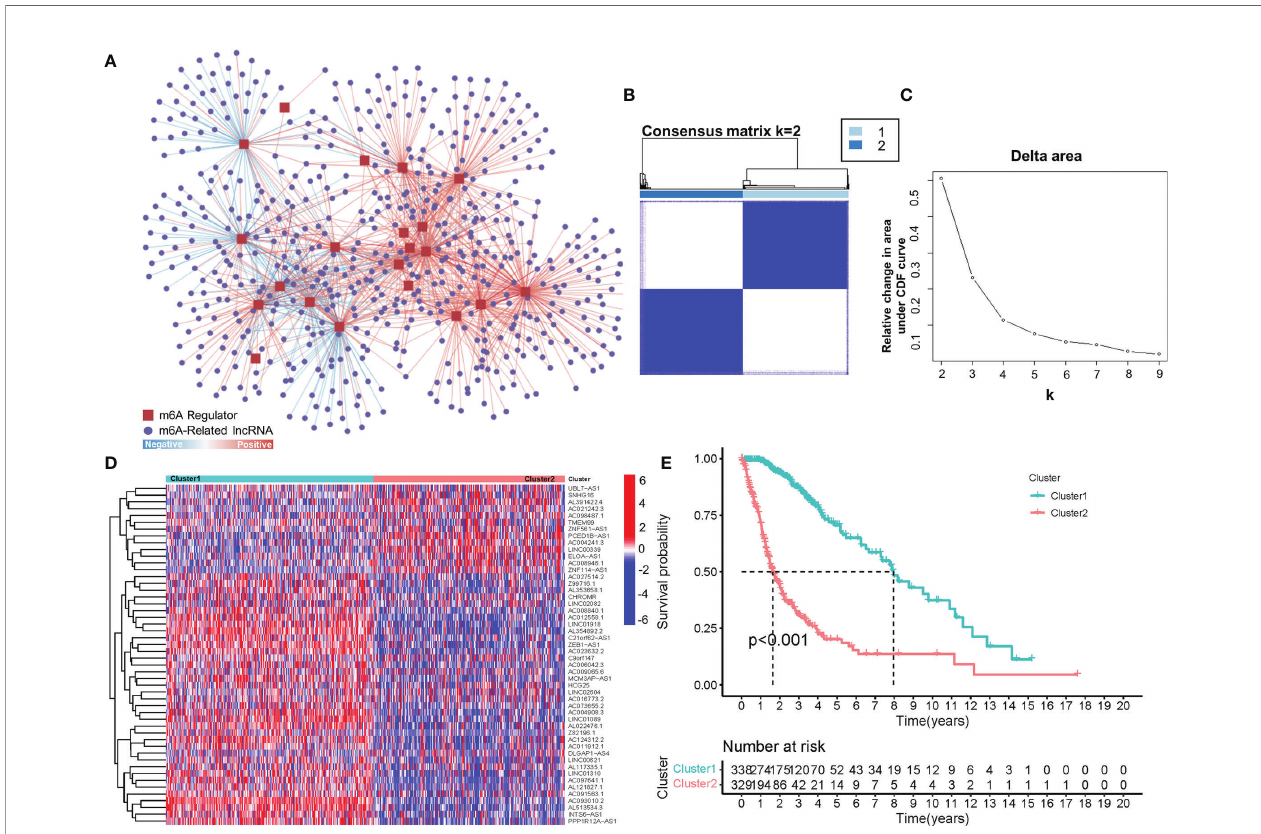
FIGURE 1 | (A) The coexpression network of m6A regulators and m6A-related lncRNAs. (B) Consensus matrix of the consensus clustering based on the m6A- related lncRNAs for optimal k = 2. (C) Area under the CDF curve increment for k = 2 to 9. (D) The heatmap of 50 randomly m6A-related lncRNAs in 2 clusters. (E) Overall survival of patients (TCGA) in different